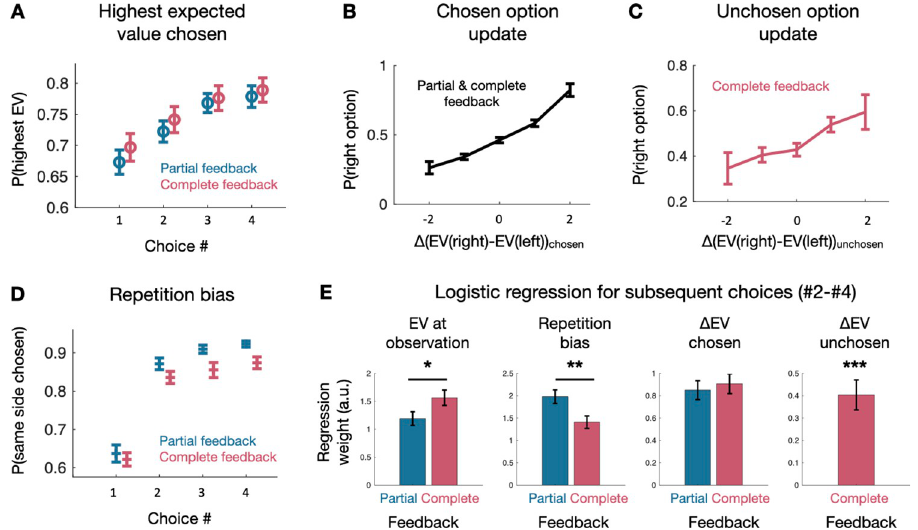
Fig 3. Behavioral update. ( A ) As monkeys progressed through the long horizon, they were more likely to choose the option with the higher expect reward in both the partial and complete feedback condition. Mean across sessions (partial feedback: 41 sessions, complete feedback: 40 sessions). ( B ) Monkeys were sensitive to changes in the expected value compared to the baseline expected value they experienced during the observation phase both for the chosen option (mean across all sessions (81 sessions)) and ( C ) the unchosen option (mean across all complete feedback sessions (40 sessions)). ( D ) Monkeys were also more likely to repeat their choice as they progressed through the long horizon. Mean across sessions (partial feedback: 41 sessions, complete feedback: 40 sessions). ( E ) Results of the single logistic regression model predicting second, third, and fourth choices in the long horizon. In both the partial and complete feedback, monkeys were sensitive to the expected value at observation but more so in the complete than the partial feedback condition (left). Monkeys tended to repeat previous choices in both conditions but more so in the partial than in the complete feedback condition (center left). In both conditions, monkeys were sensitive to the change in expected value compared to the observation phase with no significant difference between conditions (center right). In the complete feedback condition, monkeys were also sensitive to the change compared to baseline of the additional information they received. Error bars represent standard error to the mean in A-D and standard deviation in E. � p < 0.05, �� p < 0.01, and ��� p < 0.001. Data and code to reproduce the figure can be found at https://doi.org/10.5281/